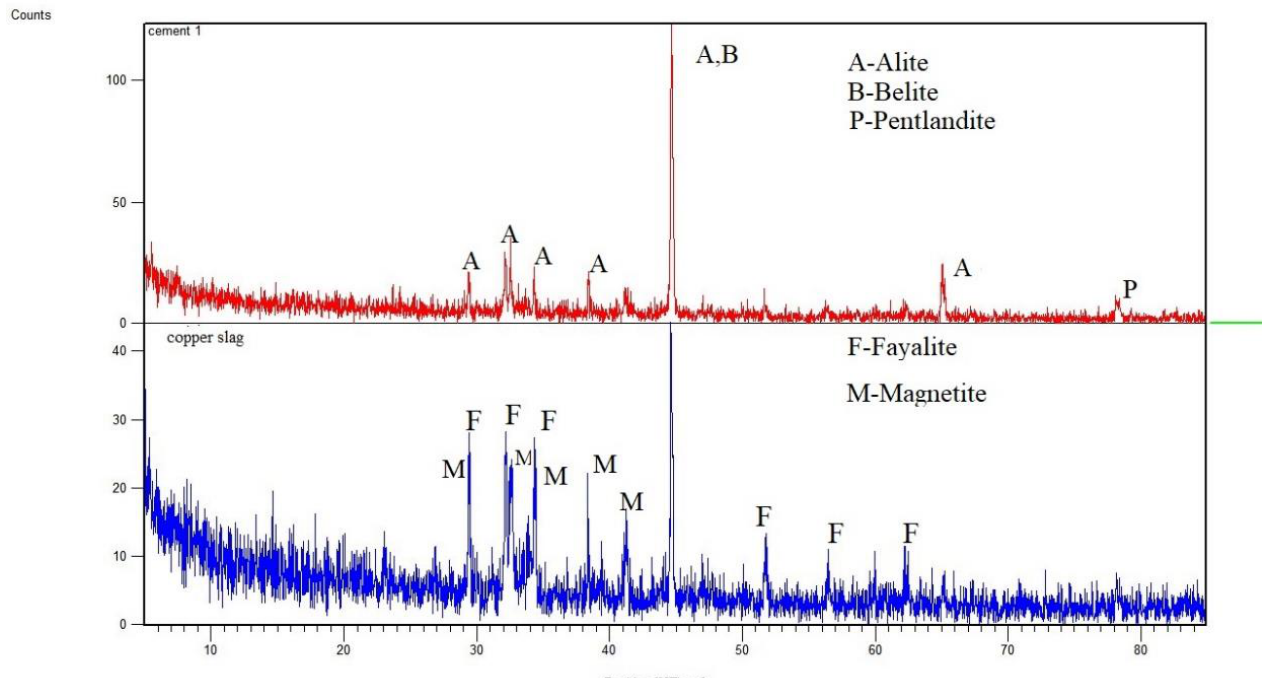
Figure 9. XRD analysis comparison of cement and CS.